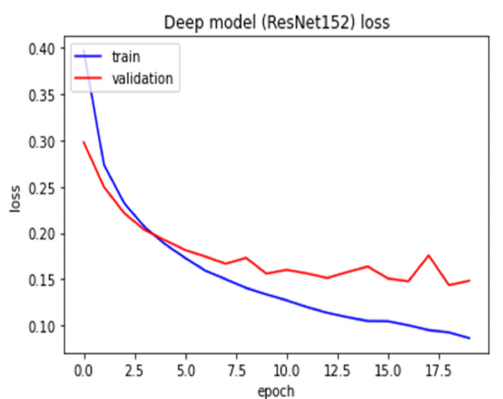
Figure 17. Losses of model based on 20 epochs for ResNet152.